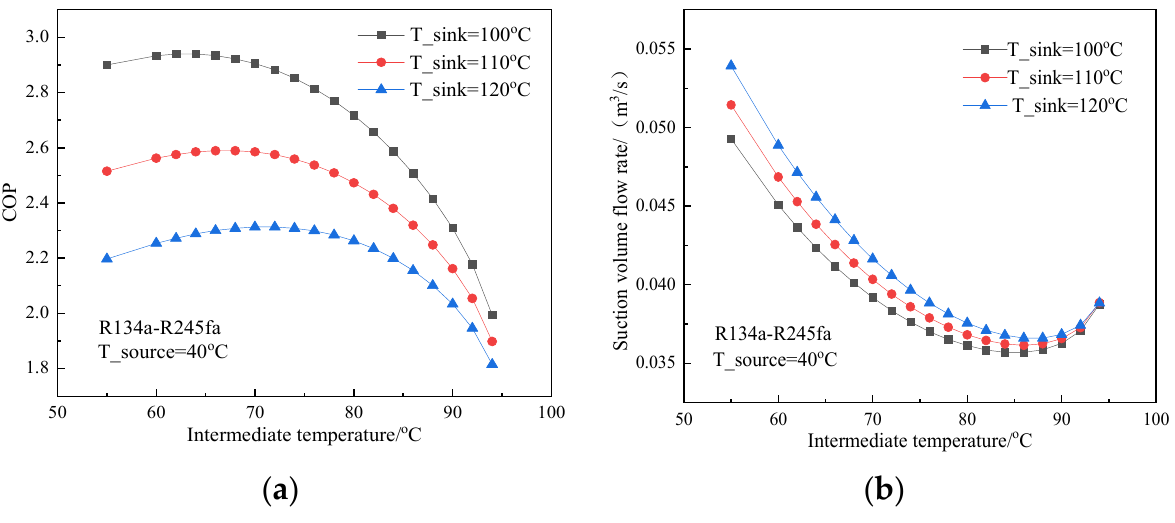
Figure 3. Effects of the intermediate temperature on the thermodynamic performance. ( a ) COP at var- ious intermediate temperatures. ( b ) Suction volume flow rate at various intermediate temper- atures.